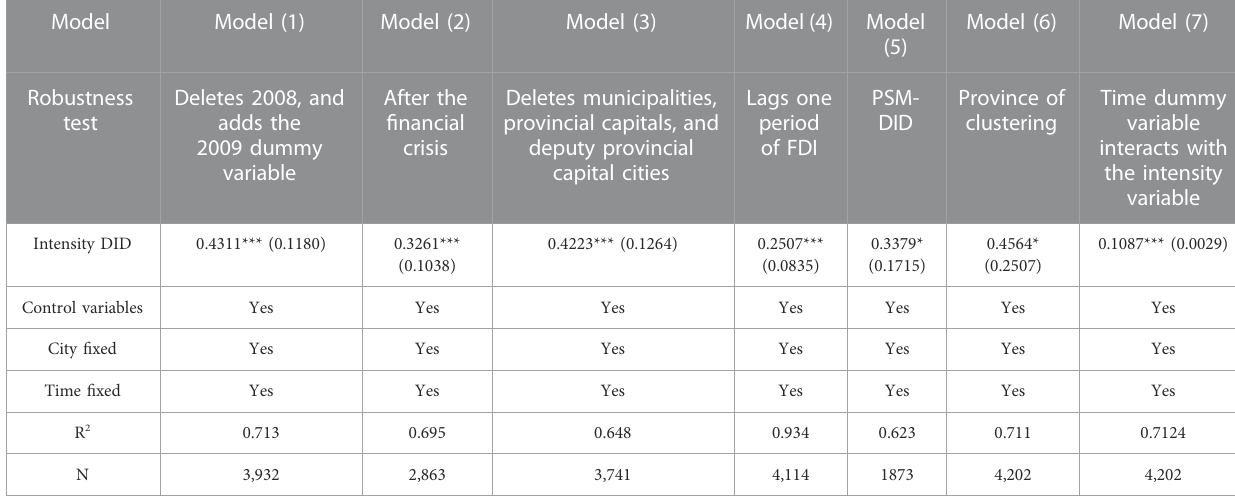
Table 3. The identi fi cation method of this paper is to use the median